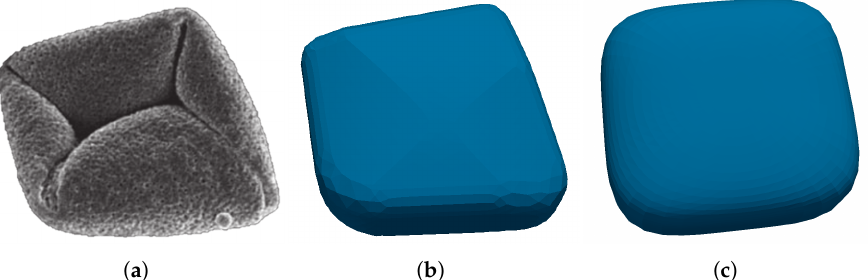
Figure 10. Pollen grain in consideration for testing the performance of the present model. The picture of the original particle [51] is shown in ( a ), reprinted with permission from [51], copyright 2016 John Wiley and Sons. In ( b ) the reconstructed 3D surface of the particle is displayed and in ( c ) the best matching superellipsoid ( λ 1 = 1.96, λ 2 = 1.83, e 1 = 0.564, e 2 = 0.472) is